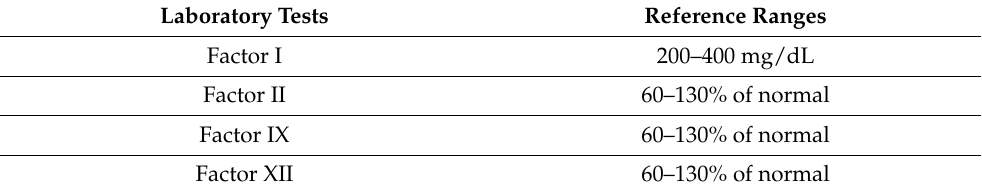
Table 3. American Board of Internal Medicine—Laboratory test reference ranges January 2023